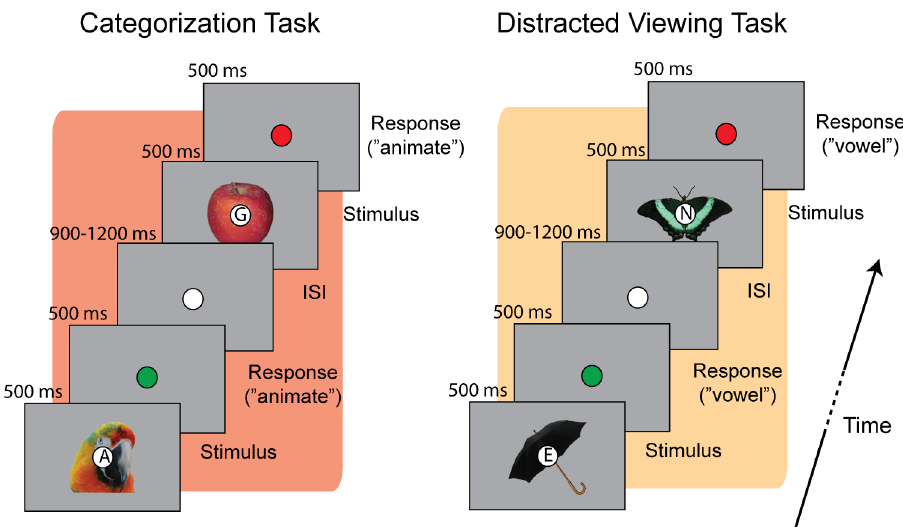
Fig 2. Behavioral paradigm. Trial structure for the two experimental tasks. On each trial a letter (vowel or consonant) was superimposed on the fixation circle in the centre of each object exemplar. When performing the categorization task subjects judged whether the exemplar stimulus was animate or inanimate, while during the distracted viewing task subjects judged whether the letter was a vowel or consonant. After subjects responded the fixation circle briefly flashed green (correct response) or red (incorrect response or no response) to provide trial-by-trial feedback on performance.